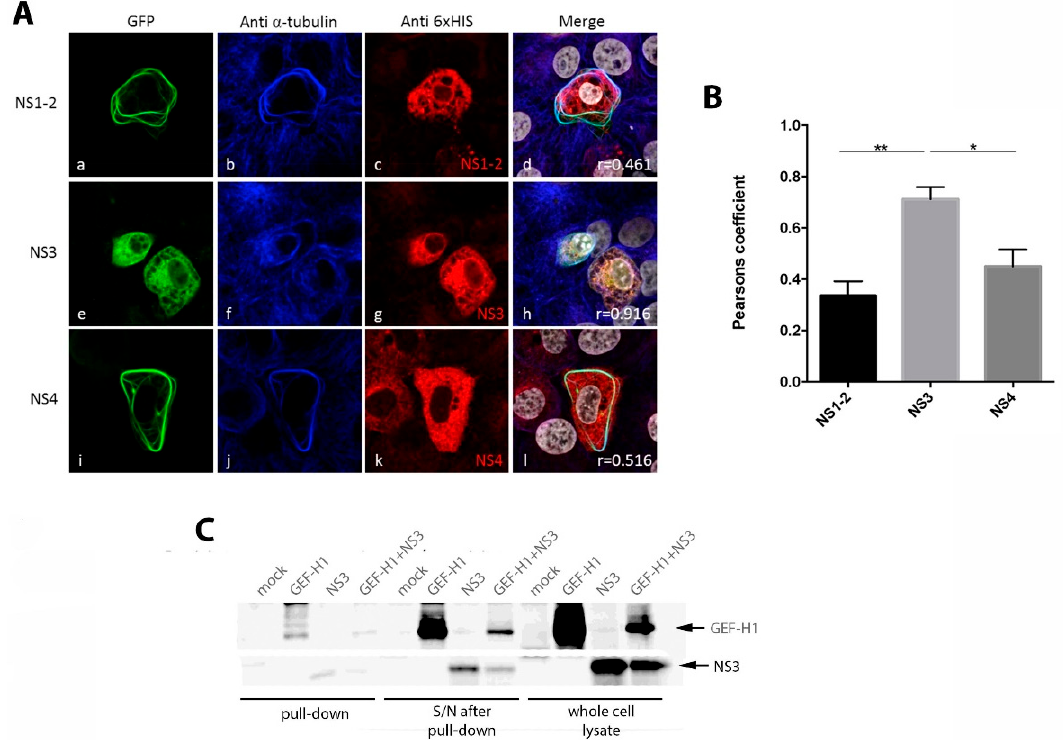
Figure 3. Co-expression with non-structural protein 3 (NS3) changes the GEF-H1 morphology. ( A ) Vero cells were co-transfected with GEF-H1-GFP WT and the HIS-tagged viral proteins. Cells expressing GEF-H1-GFP is shown in panels a, e, and i (green). Panels b, f, and j display the staining with an anti- α –tubulin antibody (blue), while panels c, g, and k show the antibody staining for anti-6 × HIS (red). Panels d, h, and l represent the merged image of all channels including the nuclear stain (grey). Co-transfected cells displayed the typical bundle-like structures of GEF-H1 in the cell periphery, except for cells co-transfected with NS3. NS3 and GEF-H1 WT appeared to co-localise and a rather reticular distribution of GEF-H1 could be observed. Additionally, GEF-H1 WT appeared to change the distribution of NS3 as well, compared to cells transfected with NS3 only. The co-localisation was quantified with the Pearson’s coefficient and is indicated in the merged image. ( B ) Quantitation of the Pearson’s coefficients. NS1–2 = 0.34 ± 0.20 ( n = 9), NS3 = 0.70 ± 0.11 ( n = 17), and NS4 = 0.45 ± 0.13 ( n = 9). Bars represent average ± SEM and * = p < 0.05 and ** = p < 0.01. Images were collected over triplicate experiments and analysed in GraphPad Prism. ( C ) The 293T cells were co-transfected with cDNA expression plasmids encoding for 6 × HIS-tagged NS3 and GEF-H1-GFP proteins, and cell lysates were analysed via immune precipitation. Lysates were incubated with a cOmplete TM His-Tag Purification Resin to pull down the 6 × HIS-tagged NS3 and possible interaction partners. Lysates were then transferred to a nitrocellulose membrane for immunoblotting with anti-GFP and anti-6 × HIS antibodies and visualised by chemiluminescence. A representative image from three independent experiments is